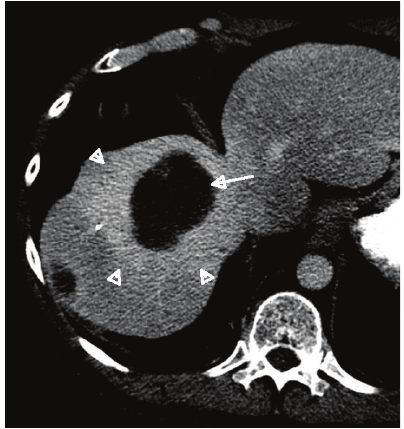
Figure9:49-year-oldfemalepatientwithmelanoma.IntheCTscan performed 3 months after treatment a hypodensity (arrowheads) around the treated lesion (arrows) is seen. Of note, a radiopaque fiducial seed is seen laterally to the lesion.